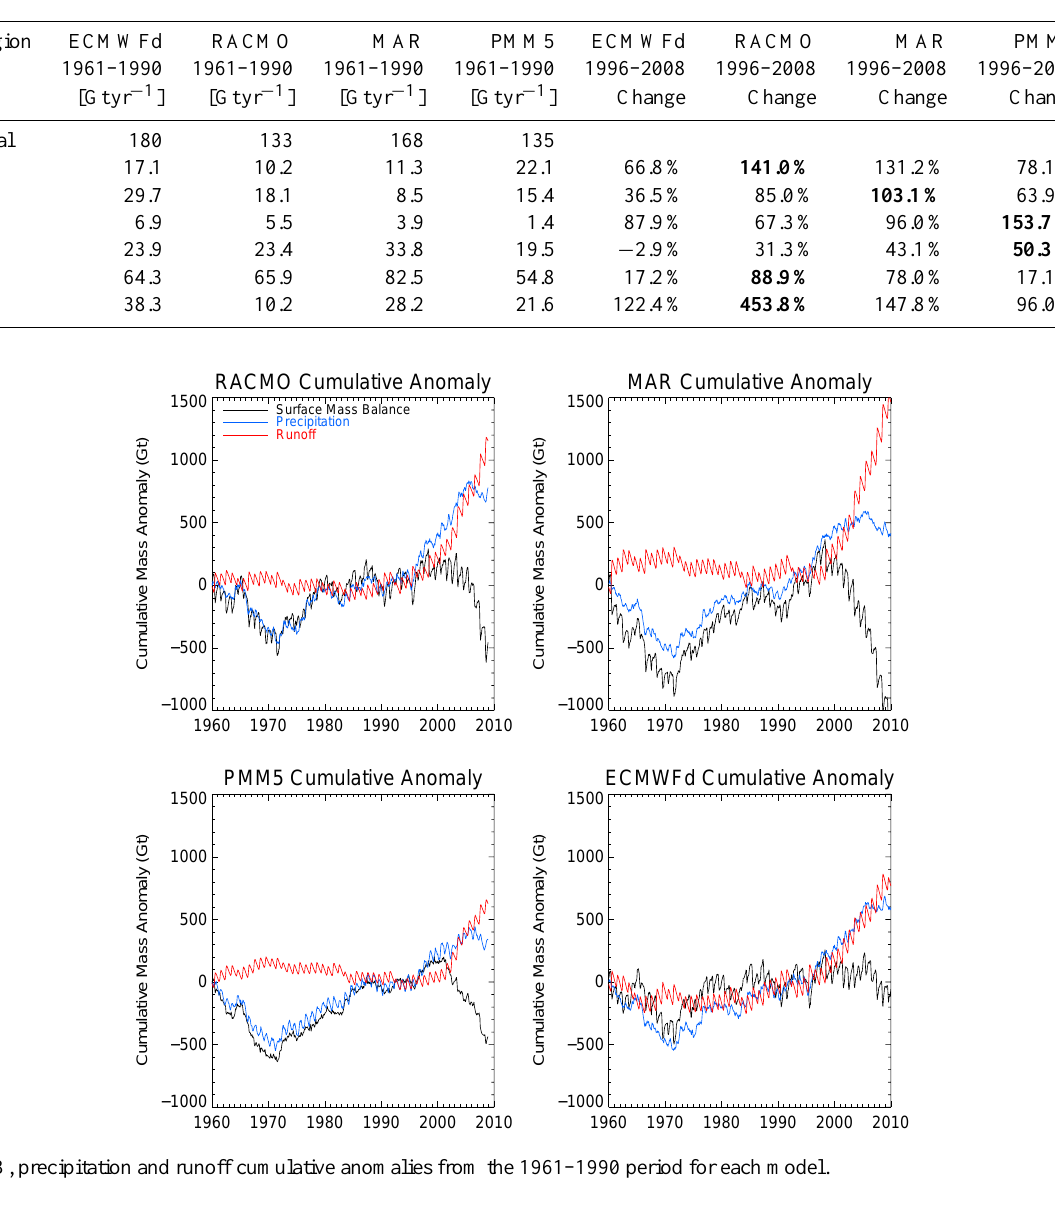
of accumulation processes. Above the ELA there is net